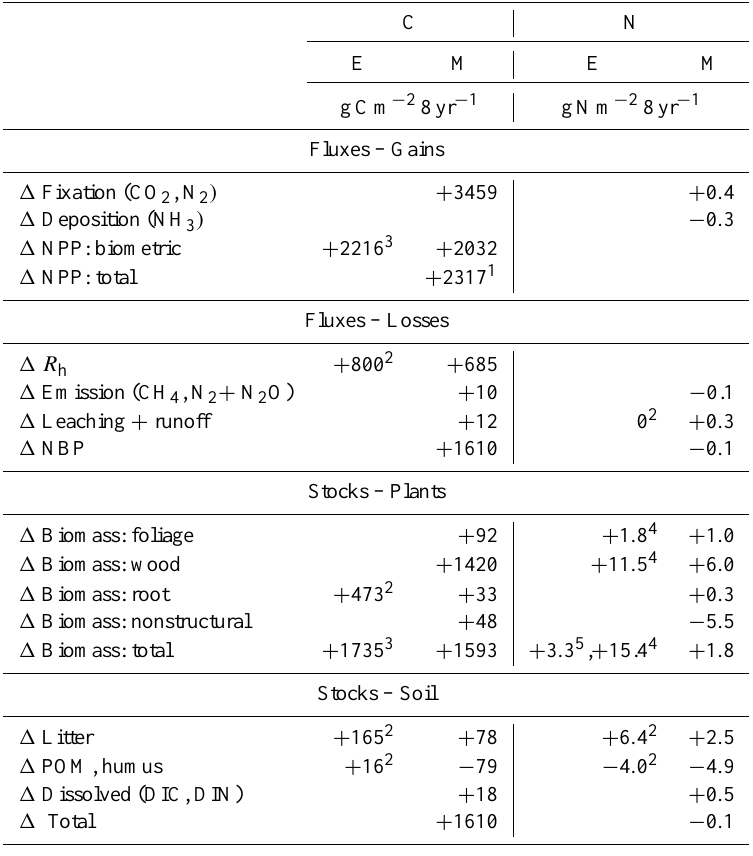
Table 1. Differences in cumulative fluxes and stocks of C and N estimated from biometric measurements (E) or modelled (M) at the